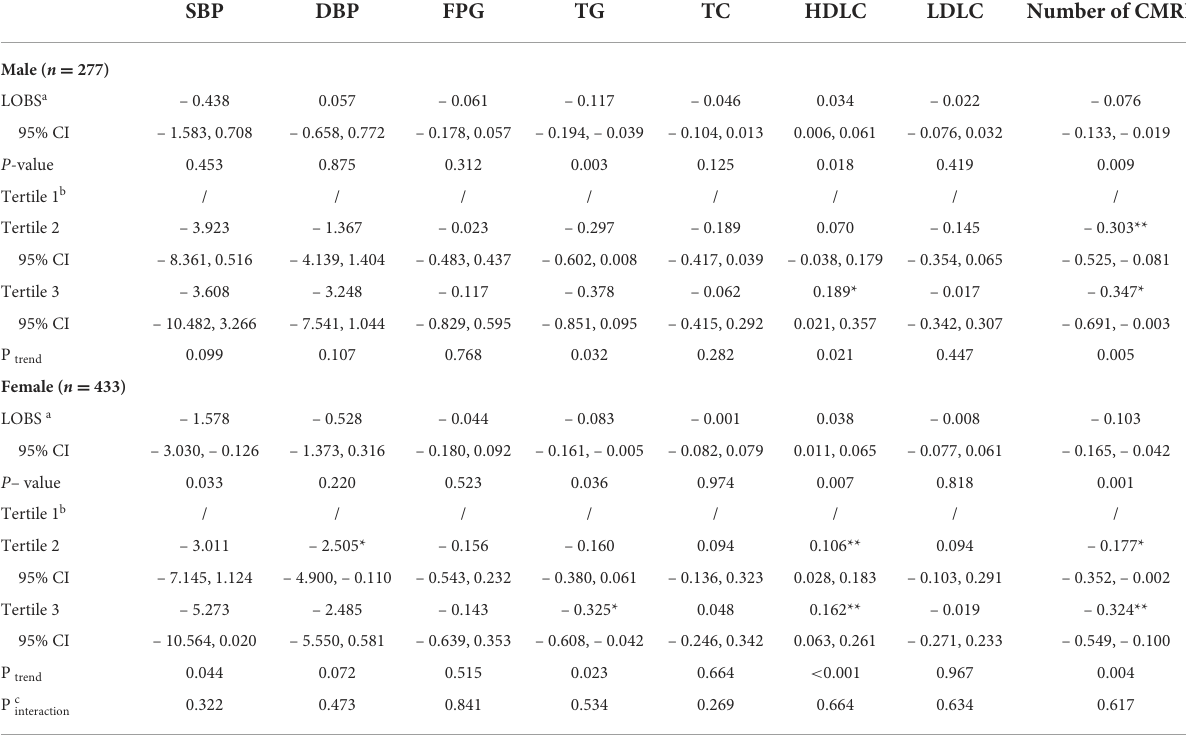
TABLE 5-1 Associations of the lifestyle-based oxidative balance score with the number of cardiometabolic risk factors and cardiometabolic biomarkers by gender using linear